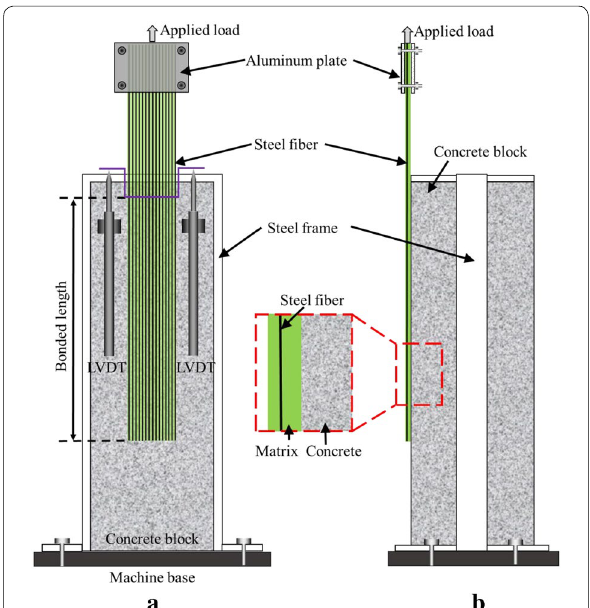
Fig. 4 Single-lap direct shear test setup: a front view, and b side